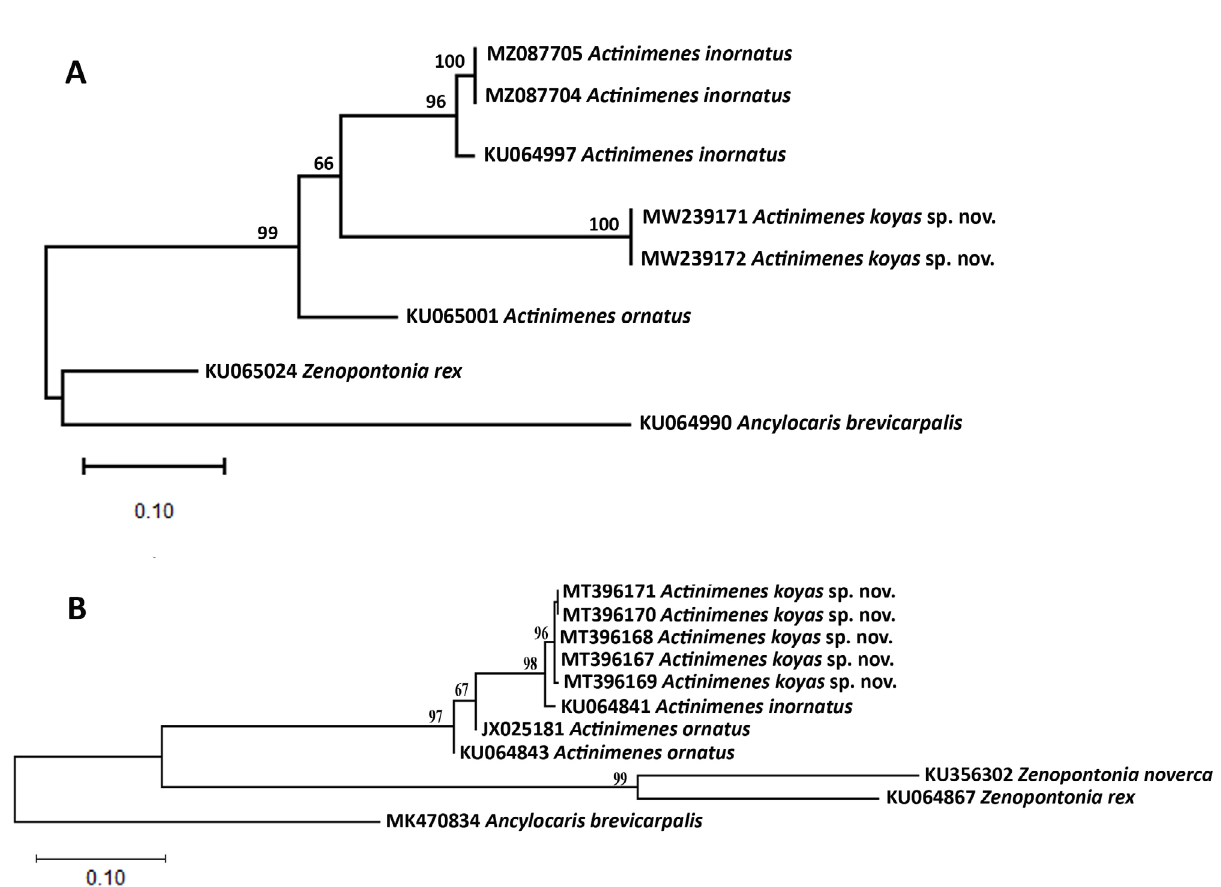
Figure 7. Maximum Likelihood phylogenetic tree based on partial COI ( A ) and 16S ( B ) sequences of Actinimenes koyas sp. nov. and two other Actinimenes species obtained from GenBank (Scale bar = 10 % divergence; significant bootstrap value > 60).